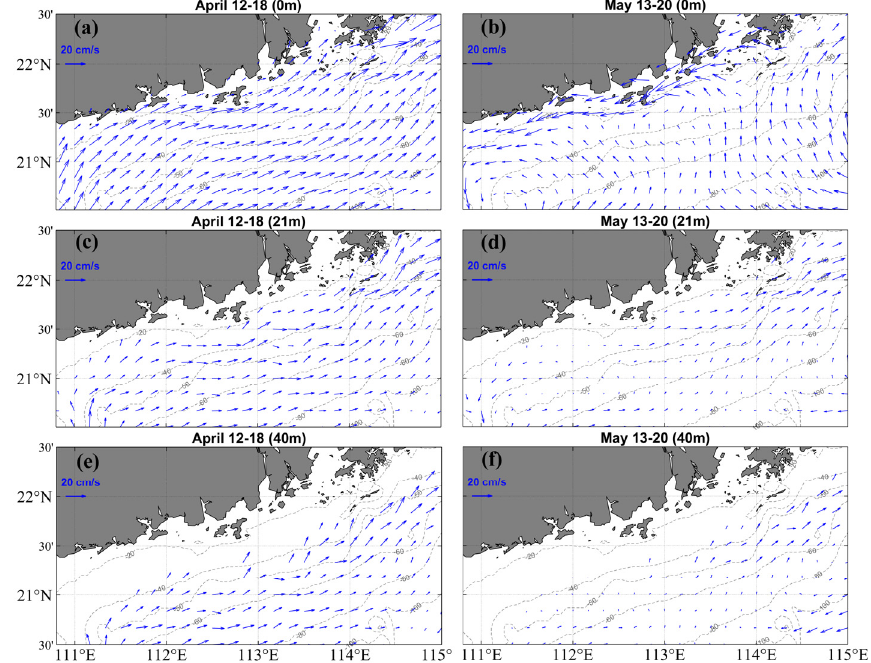
Figure 9. The mean CMEMS model currents at 0 m ( a , b ), 21 m ( c , d ) and 40 m ( e , f ), averaged over 12–18 April ( a , c , e ) and 13–20 May ( b , d , f ) 2016. The subtitle in each subplot indicates the corresponding time and depth. The dashed lines denote the water depths (in meters).